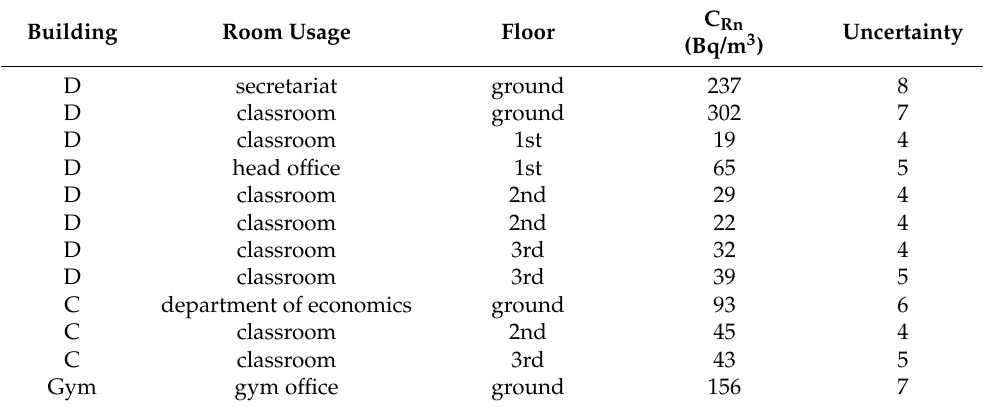
Table 2. Location of rooms and the variation of indoor radon concentration in school 1.